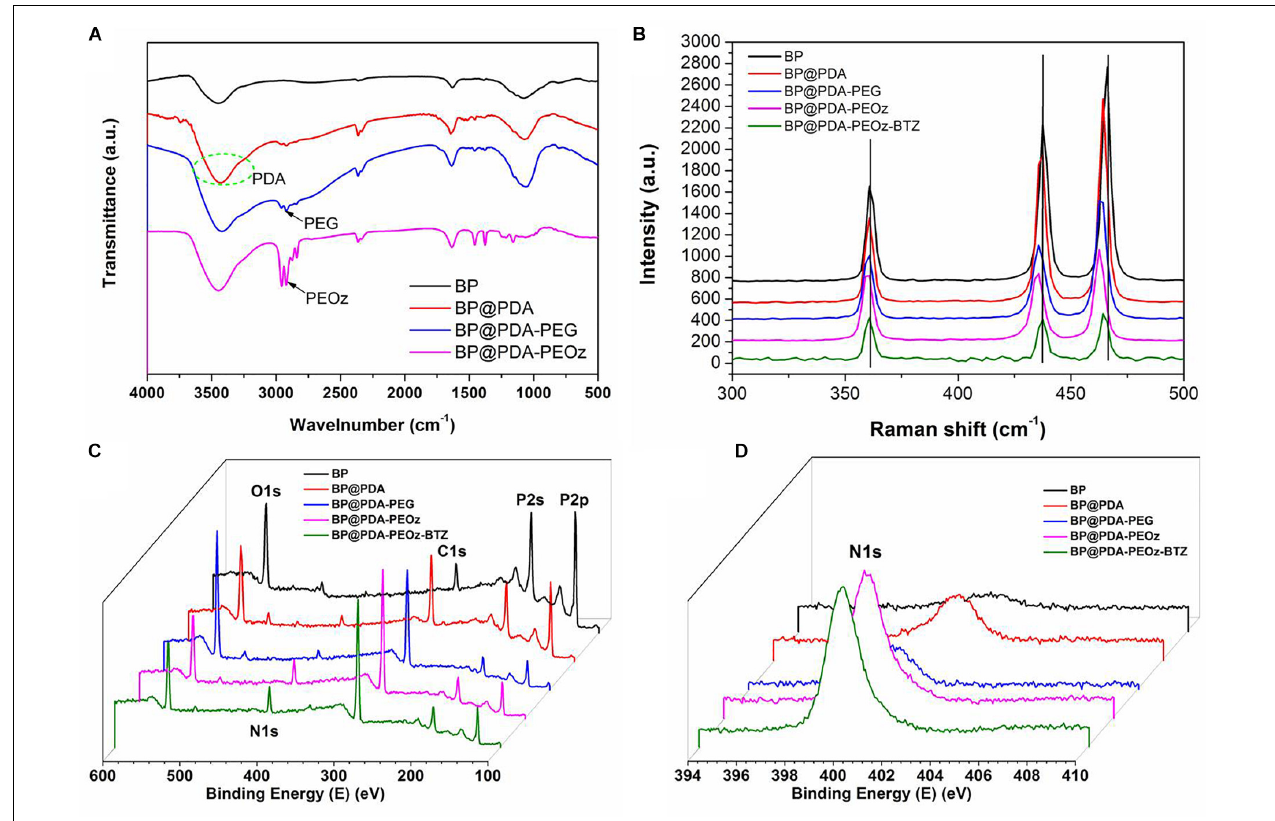
FIGURE 3 | (A) FTIR spectra of BP NSs, BP@PDA NSs, BP@PDA-PEG and BP@PDA-PEOz. (B) Raman spectra of BP NSs, BP@PDA NSs, BP@PDA-PEG, BP@PDA-PEOz and BP@PDA-PEOz-BTZ; XPS spectra of BP NSs, BP@PDA NSs, BP@PDA-PEG, BP@PDA-PEOz, and BP@PDA-PEOz-BTZ. (C) Survey spectrum and (D) N1s spectrum.